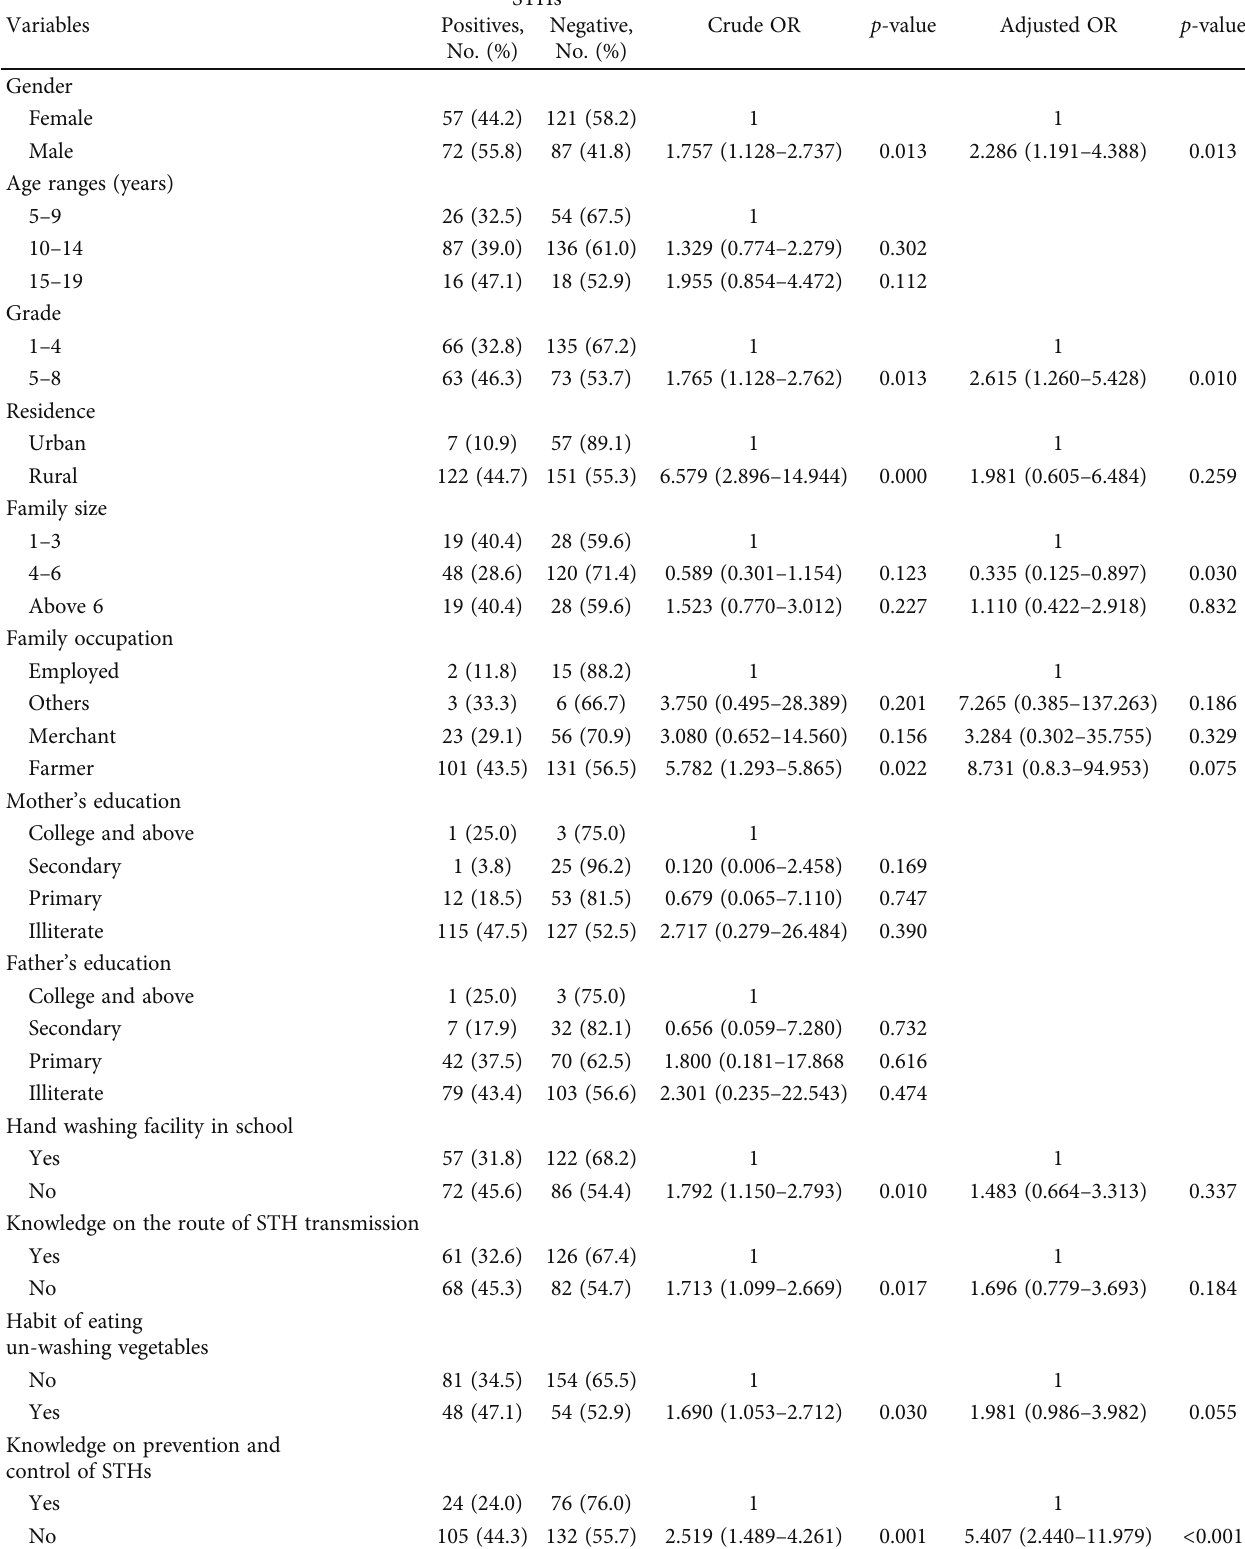
Table 4: Univariate and multivariate logistic regression analyses for sociodemographics and other potential risk factors associated with soil- transmitted helminths (STHs) infections around Lake Tana,